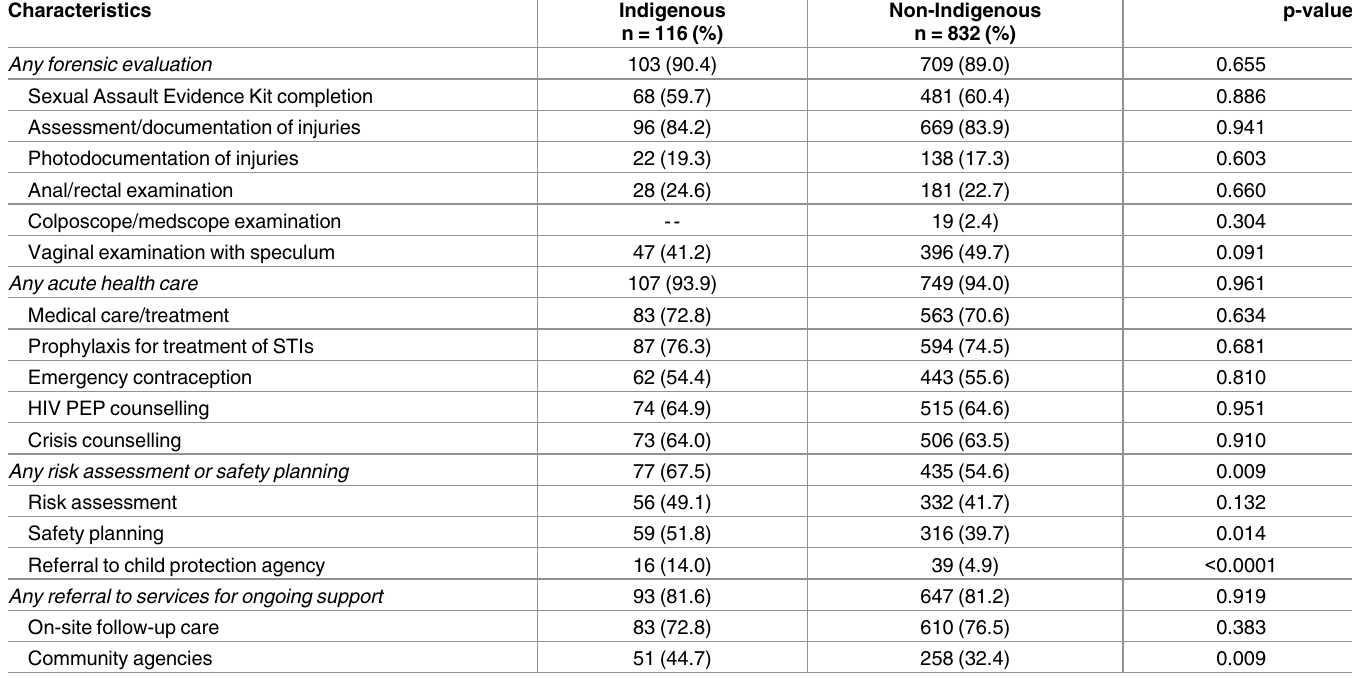
Table 5. Receipt of servicesof sexually assaulted adolescent and adult women who presented to Sexual Assault/Domestic Violence Treatment Centres, by Indigenous